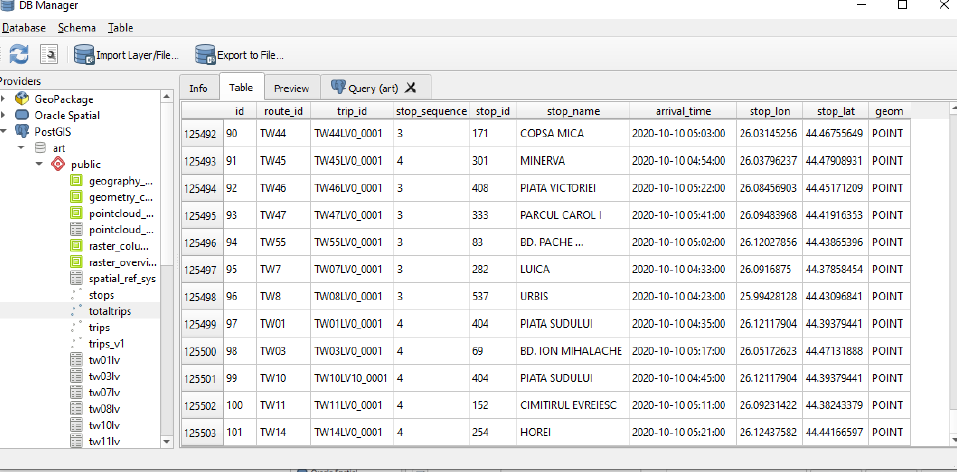
Figure 9. Extract from database with all tramlines in Bucharest.